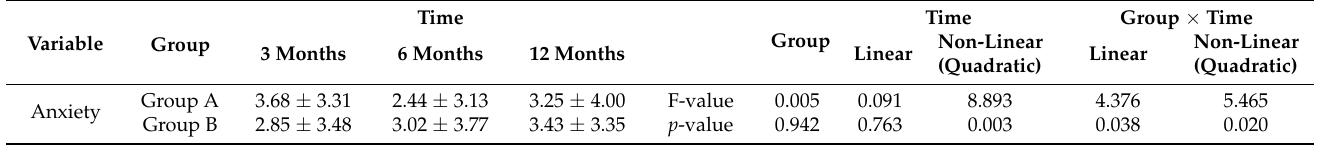
Table 3. Differences in the change of PICS scores according to time in groups A and